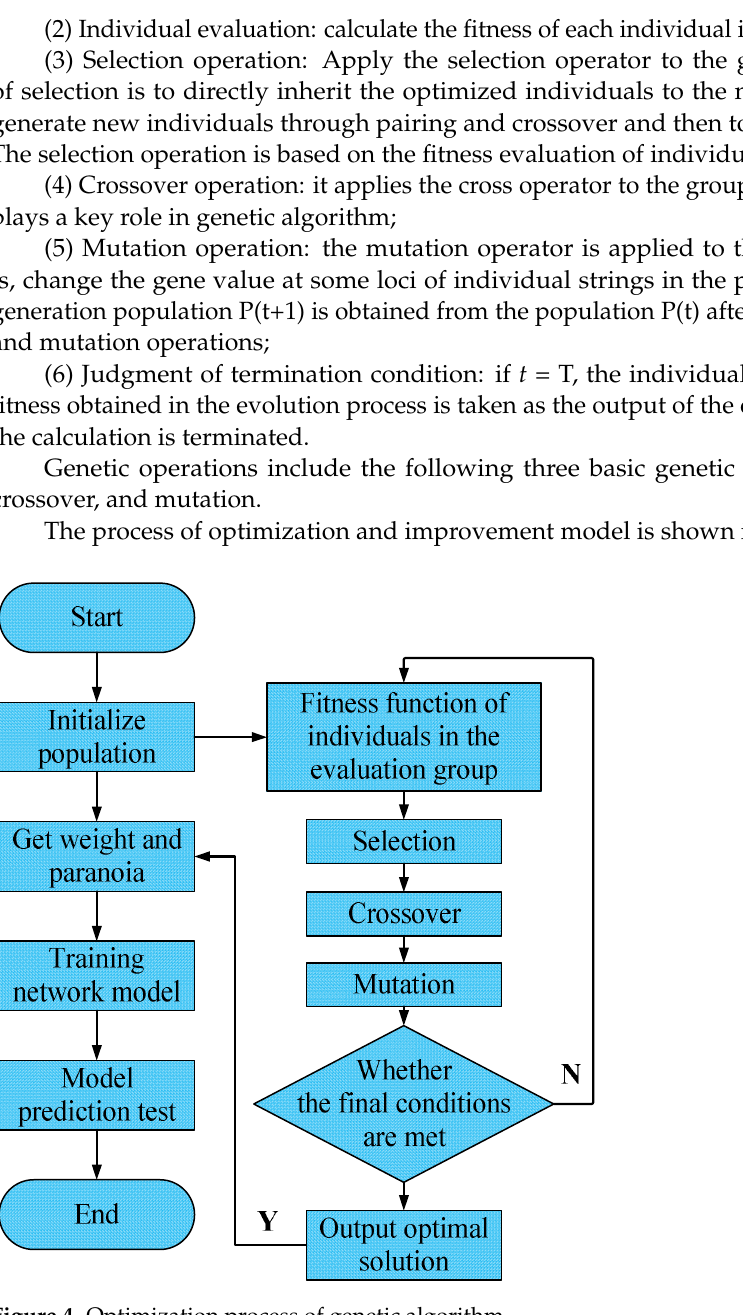
Figure 4. Optimization process of genetic algorithm.